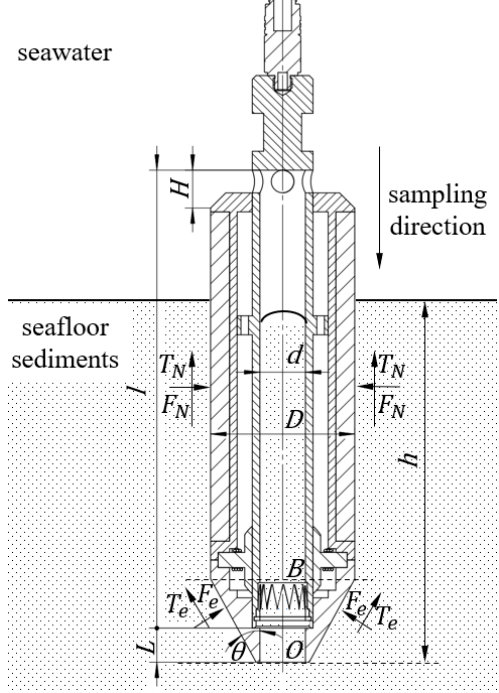
Figure 5. Schematic diagram of F fr